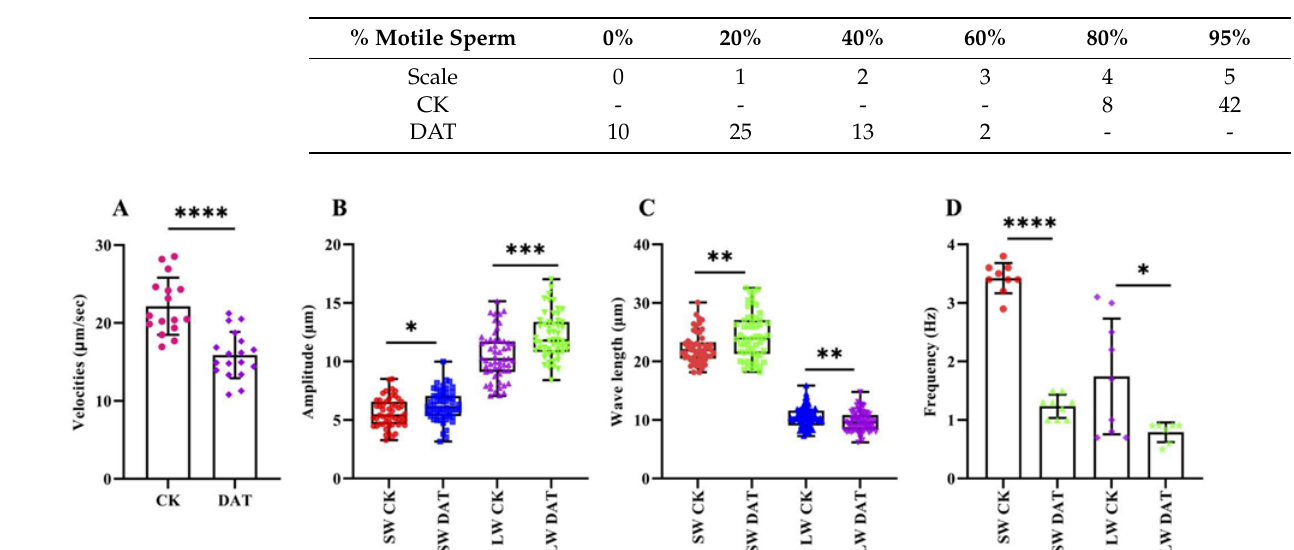
Figure 3. Female reproductive tracts of females mated with control or fumigated moths were dissected and the sperm were analyzed under a phase-contrast microscope. The videos were recorded at 17 fps and then analyzed on ImageJ for calculation of different parameters, as discussed in Methods. Velocities ( A ), amplitude ( B ), wavelength ( C ) and frequencies ( D ) were counted for all samples (unpaired two-tailed t -test, **** p < 0.0001, *** p < 0.001, ** p < 0.01, * p < 0.05).